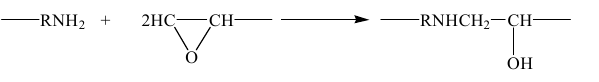
Figure 4. The curing reaction principle of epoxy resin and polyamide.